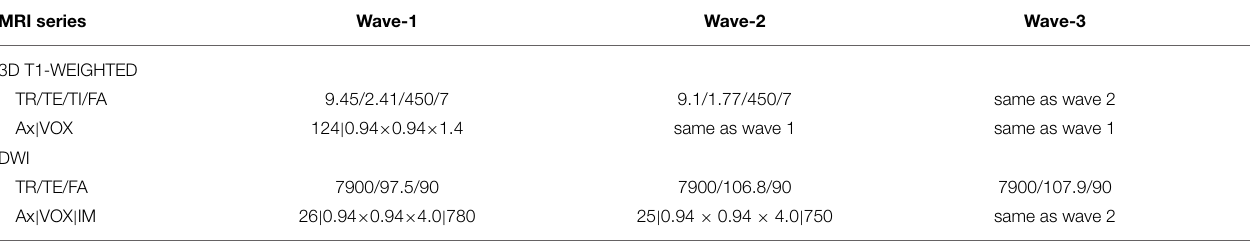
TABLE 2 | The multimodal MRI protocols used in each of the three waves (2005, 2008, and